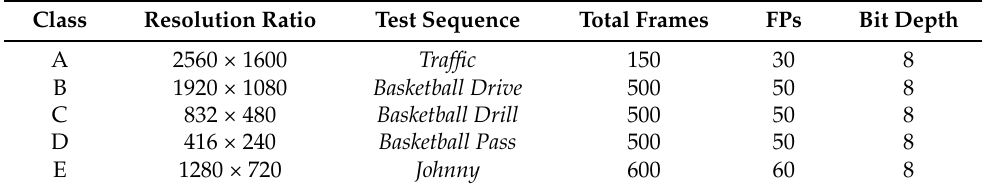
Table 1. Partly sequences of the JCT-VC test